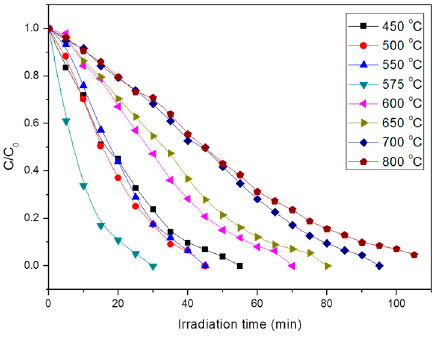
Figure 5. Photodegradation curves of Rhodamine B on TiO 2 nanofibers calcined at different temperatures.